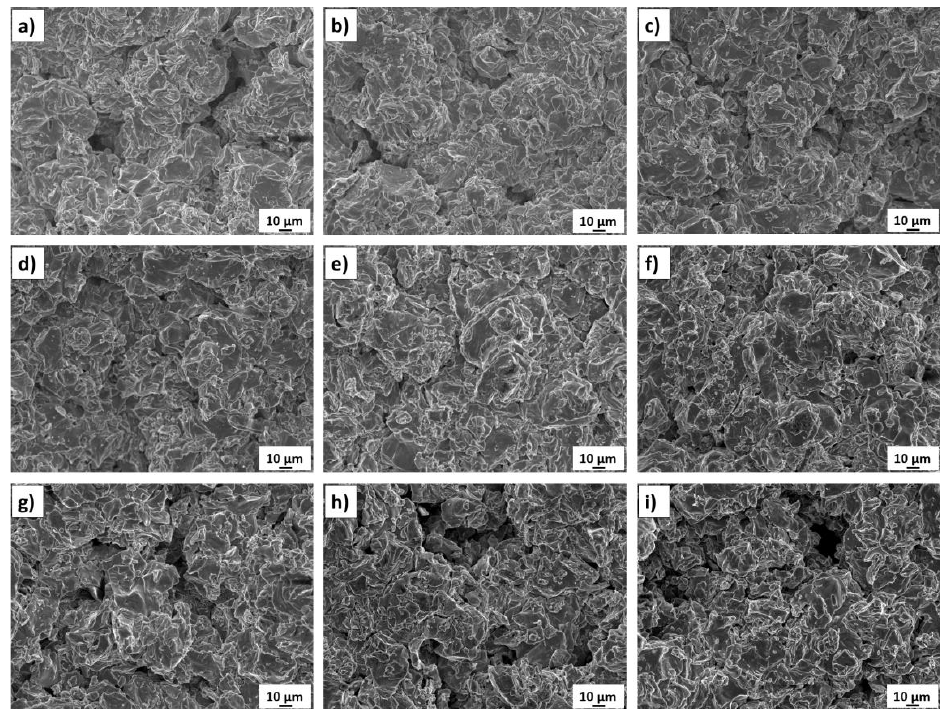
Figure 6. Surface morphologies of the cold-sprayed Ti coatings deposited at standoff distances of: ( a ) 20 mm, ( b ) 30 mm, ( c ) 40 mm, ( d ) 50 mm, ( e ) 60 mm, ( f ) 70 mm, ( g ) 80 mm, ( h ) 90 mm, and ( i ) 100 mm.